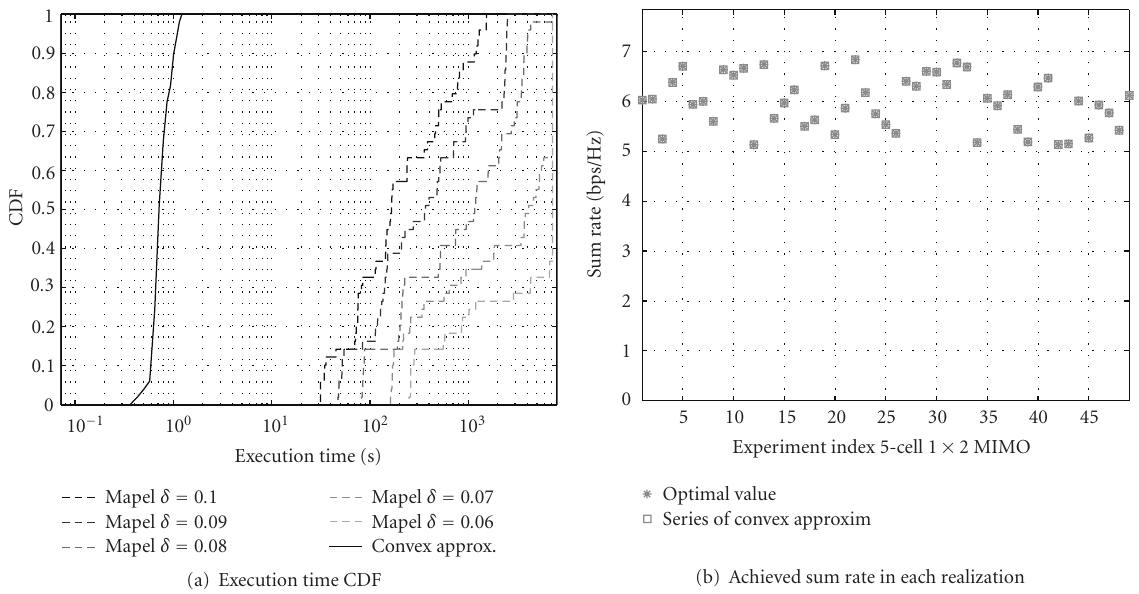
Figure 5: The iterative convexification procedure in Algorithm 1 is compared aginst the global optimization algorithm MAPEL in terms of execution time and achieved sum rate for a set of 50 channel realizations in a 5-cell 1 × 2 MIMO network with power budget set to 21.6